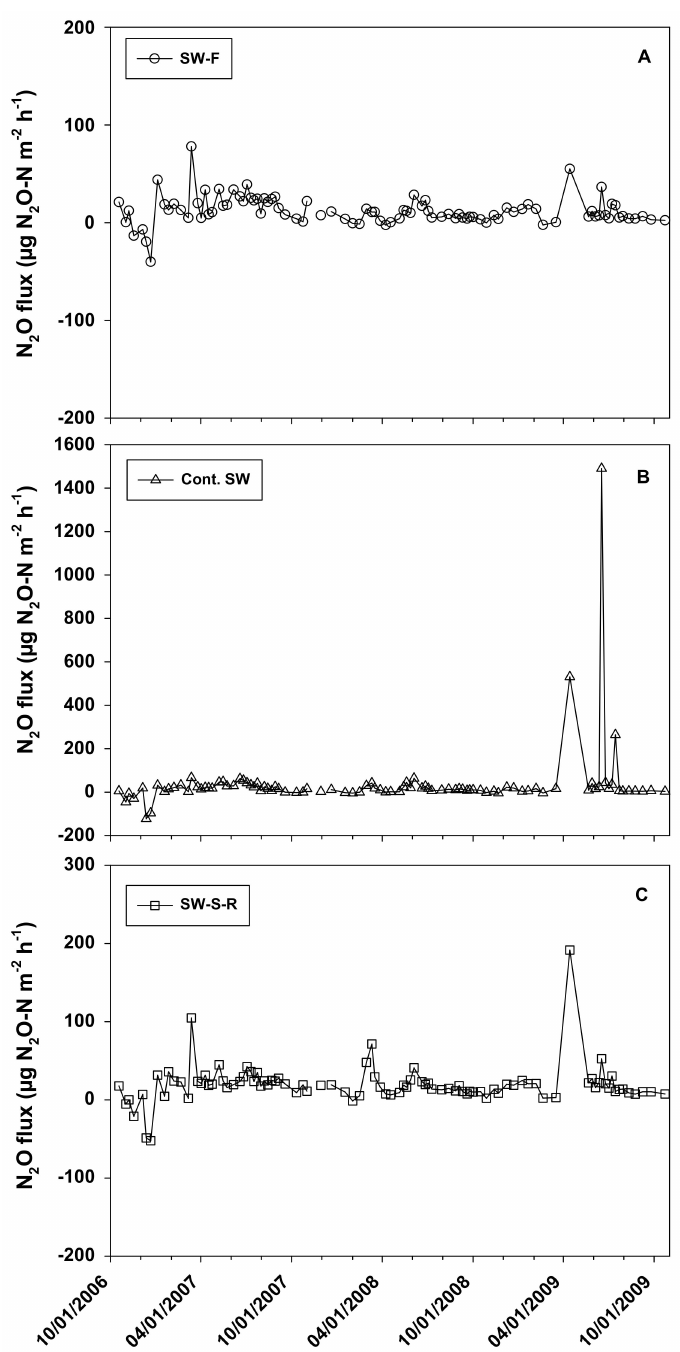
Figure 6. Nitrous oxide flux for spring wheat–fallow (SW-F; ( A )), continuous spring wheat (Cont. SW; ( B )) and spring wheat–safflower–rye (SW-S-R; ( C )) cropping systems from 18 October 2006 through 23 October 2009. Mean values are reported across crop phases for SW-F and SW-S-R. Year and season affected hourly N 2 O flux rates (Table 4). Emission of N 2 O was greater in the third year compared to years 1 and 2, a result likely facilitated by wetter soil conditions in the former (Figure 2). Nitrous oxide emission was greater in spring and summer (29.0 and 29.9 µ g N 2 O-N m − 2 h − 1 , respectively) compared to fall and winter (7.1 and 8.3 µ g N 2 O-N m − 2 h − 1 , respectively). Mean hourly N 2 O flux did not differ among crop phases and cropping systems despite large numerical differences within phases and systems. Evaluation of plot-scale data found a large proportion of positive N 2 O fluxes occurred in the third replication of the study, where inherent